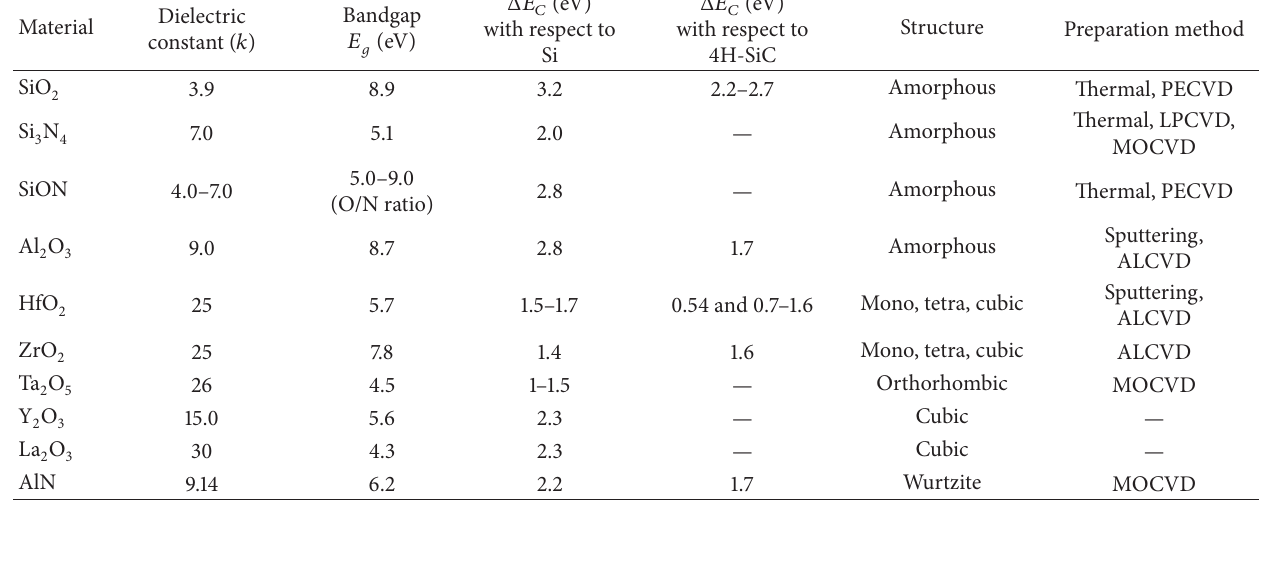
Table 1: List of physical properties of various dielectric materials reported in the literature.